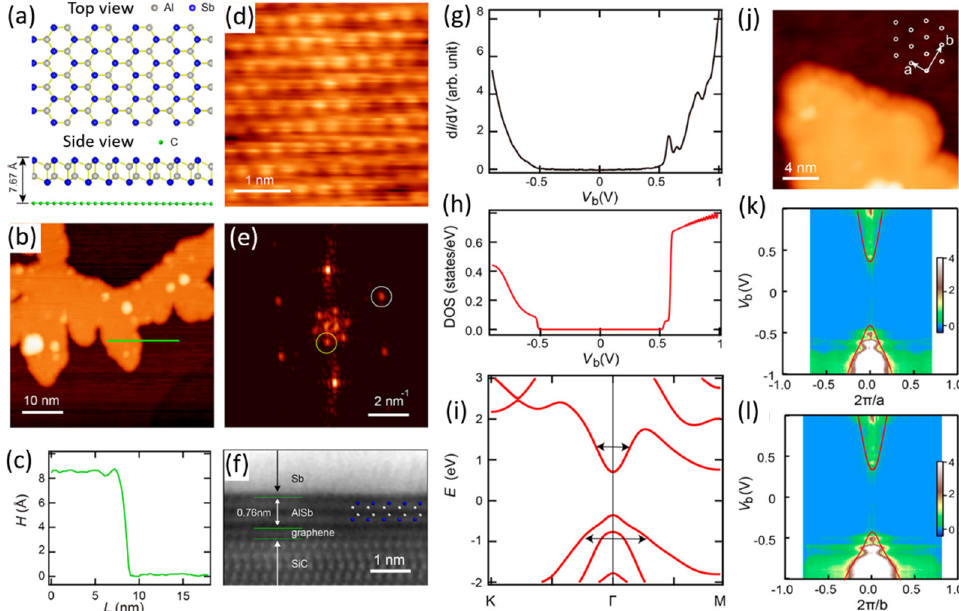
Figure 2. ( a ) Top and side views of DLHC AlSb model on graphene. ( b ) STM topography (V b = 3 V, I t = 5 pA) and ( c ) apparent height along the green line in ( b ). ( d ) STM image with atomic resolution (V b = 0.7 V, I t = 30 pA) of AlSb and ( e ) fast Fourier transformation of ( d ). ( f ) STEM image of the cross-sectional view of the AlSb film, whose thickness agrees well with the theoretical calculation in ( a ). ( g ) Averaged tunneling spectrum of DLHC AlSb (V b = 1 V, I t = 100 pA, V mod = 20 mV). ( h ) Density of states and ( i ) band structures of DLHC AlSb, obtained by HSE@G 0 W 0 approach. The arrows indicate the flatness of conduction and valence bands. ( j ) STM topography (V b = 3V, I t = 5 pA) of a DLHC AlSb island. Insert is a schematic of the top layer Sb atoms with unit vectors marked. Energy dispersion relation along the ( k ) Γ -K and ( l ) Γ -M directions. Reproduced with permission [34]. Copyright 2021, American Chemical Society.